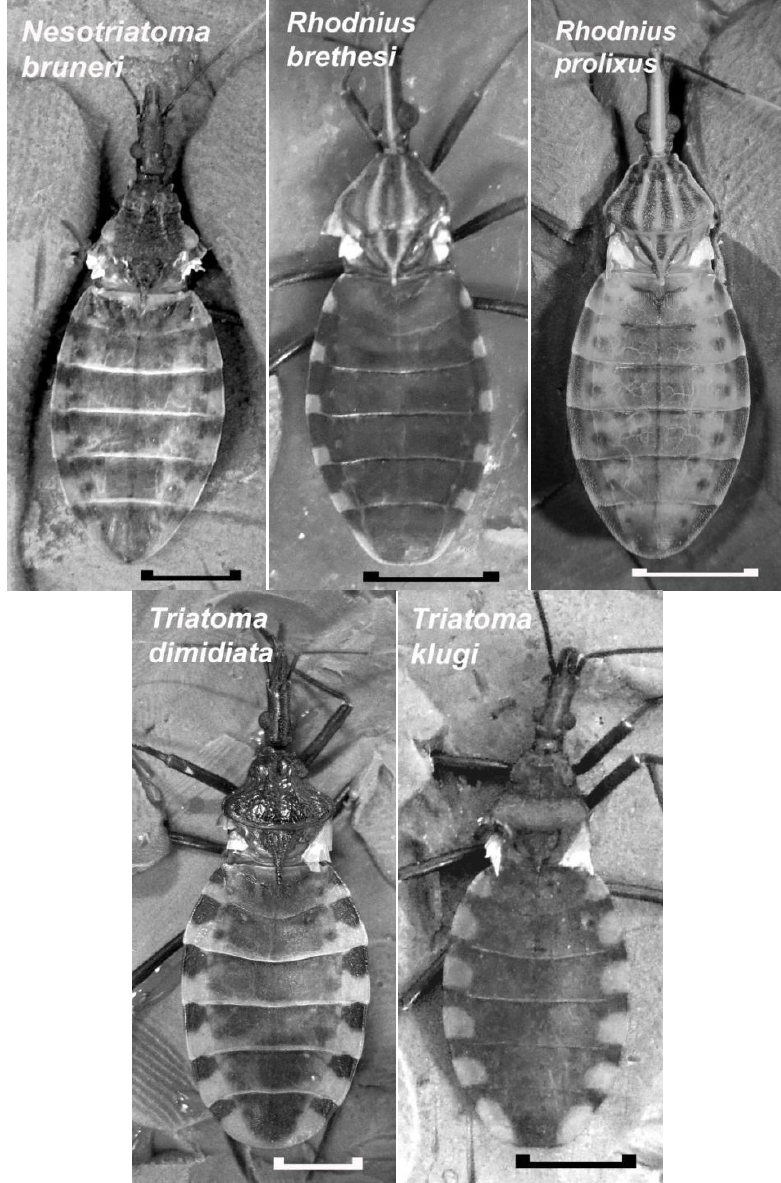
Figure 2. Dorsal view of the adult males of five species of Chagas disease vectors in which a cardio-inhibitor has been detected in crude extracts of the testes. Wings have been removed to show the similarity in the appearance of their dorsal abdominal cuticles. In these insects, the dorsal cuticle is mainly transparent and internal organs are visible when the lighting is adjusted to reduce glare. In these pictures, the dorsal vessel is clearly visible in Neotriatoma bruneri and Rhodnius prolixus as a dark line extending along the midline of the abdomen. It appears as a faint white line in R. bresethi . Scale bar: 5